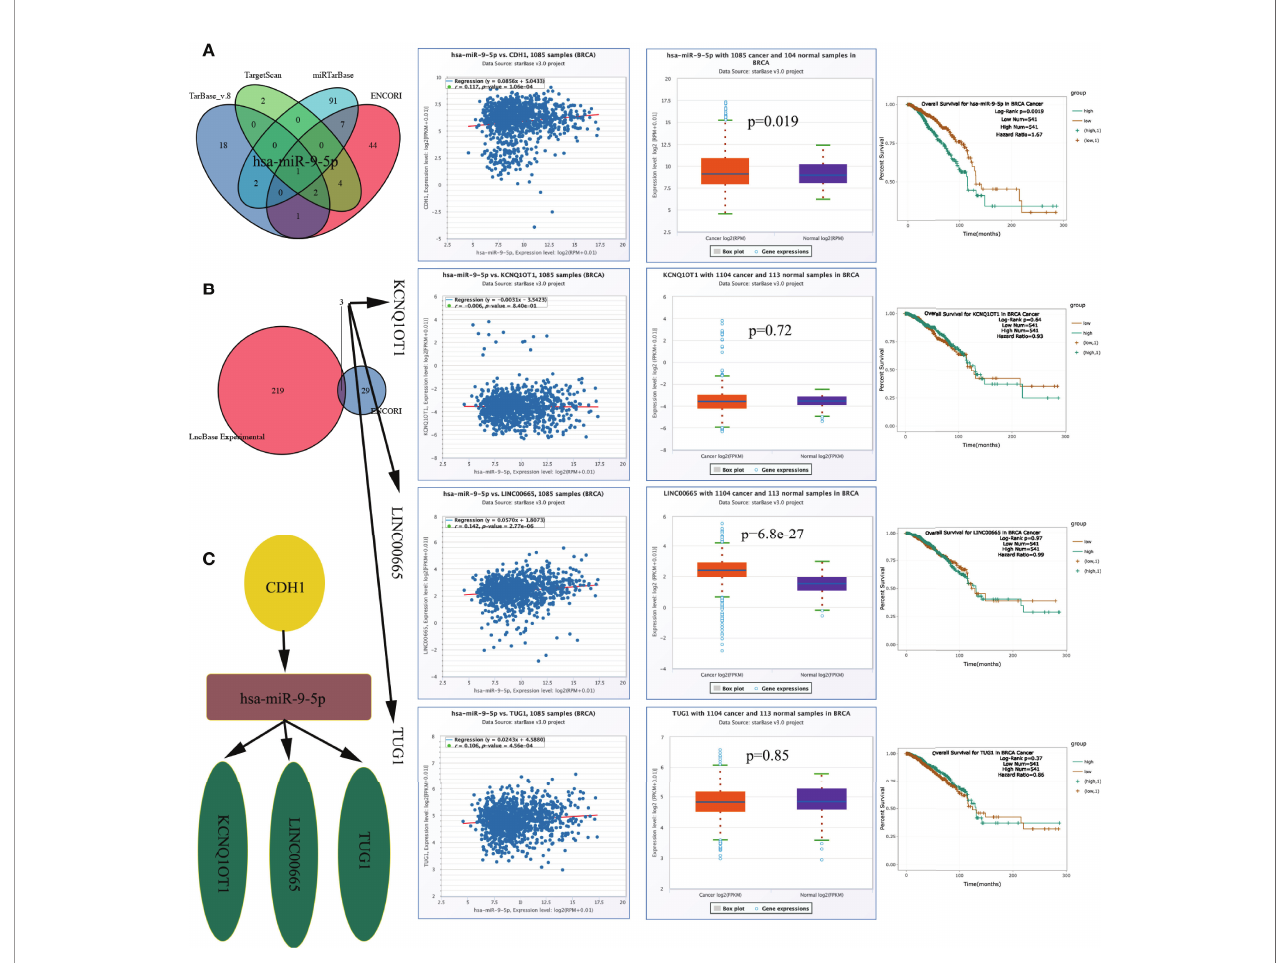
FIGURE 10 | CeRNA network construction. (A) MiRNAs predicted by ENCORI, miRTarBase, TargetScan, and TarBase, and has-miR-9-5p expression level and prognostic value. (B) LncRNAs predicted by ENCORI and LncBase Experimental, and lncRNA KCNQ1OT1/LINC00665/TUG1 expression level and prognostic value. (C) The network of lncRNA – miRNA – mRNA. ceRNA, competing endogenous